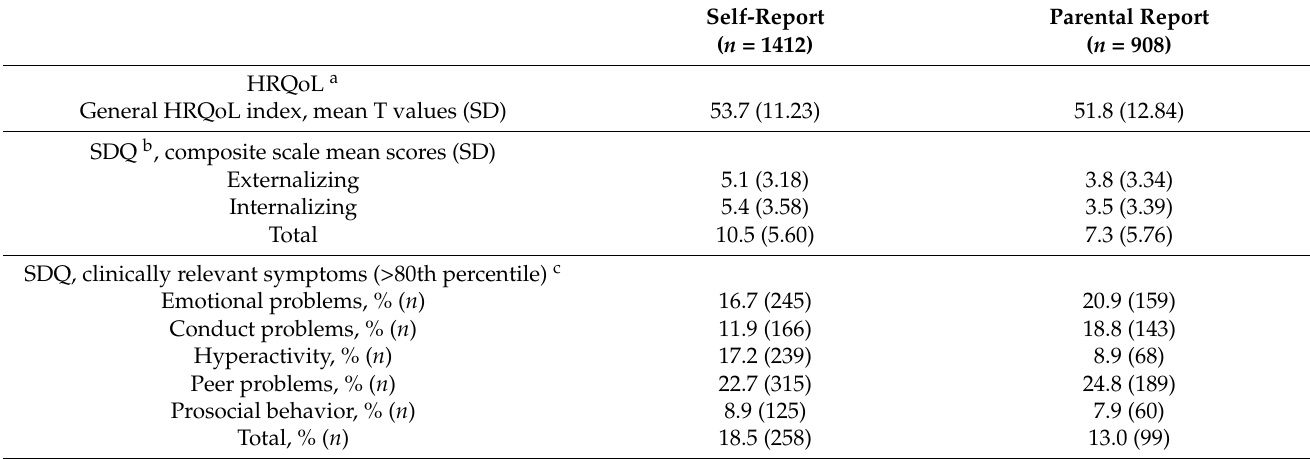
Table 1. Self- and parent-reported HRQoL and psychological symptoms in the total sample.